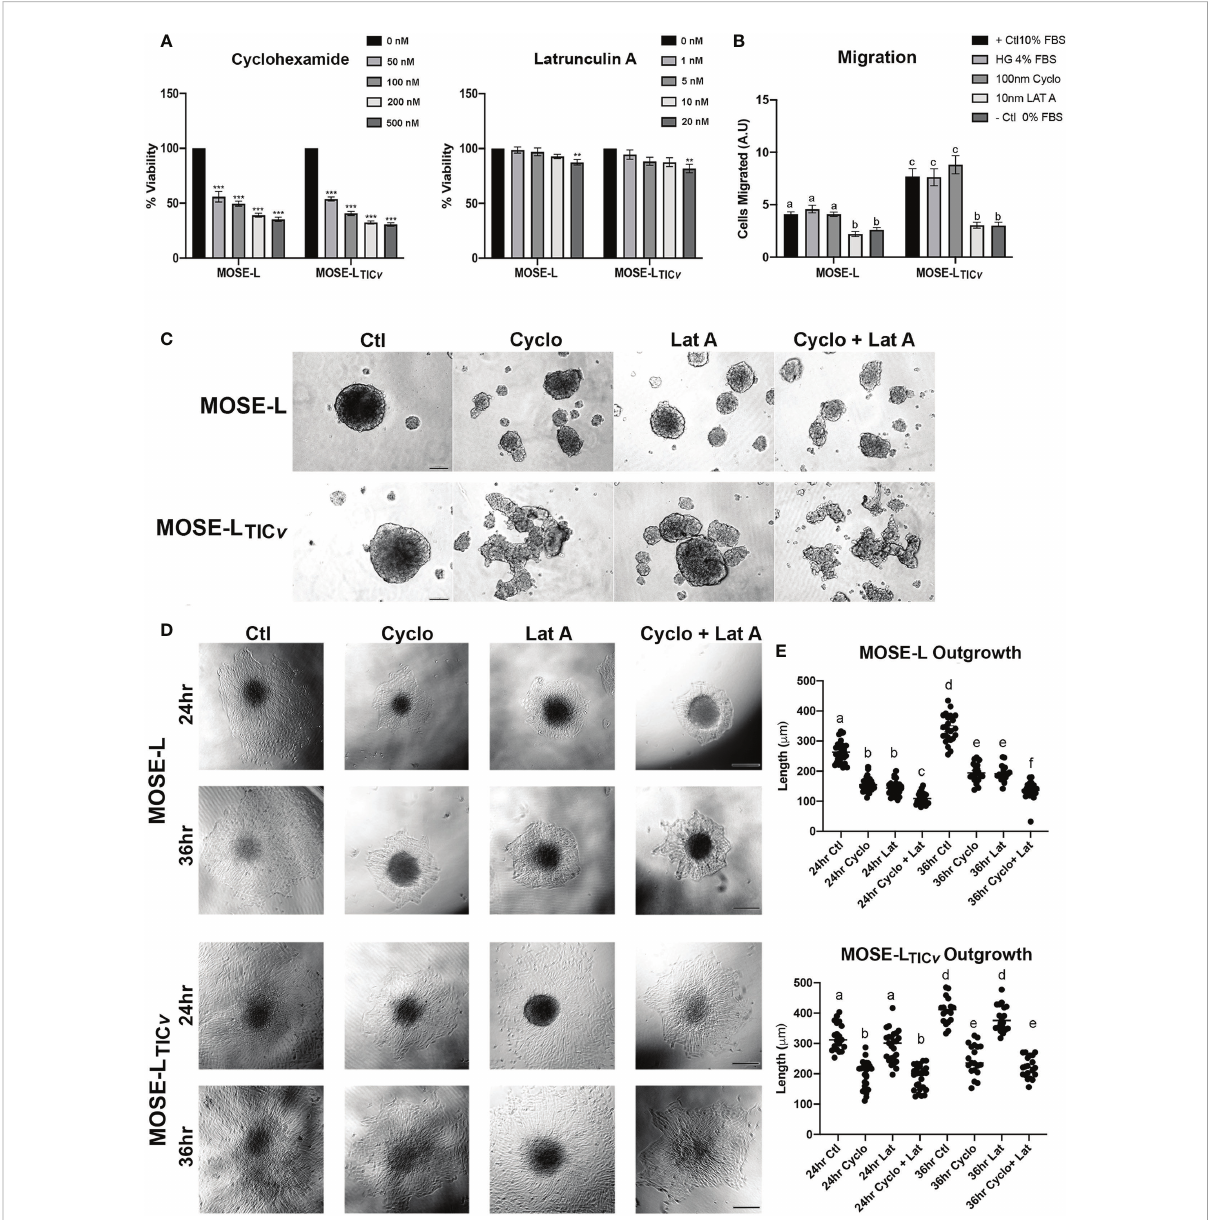
FIGURE 5 Differential effect of proliferation and migration inhibitors. (A) Inhibition of proliferation by treatment with Cycloheximide (50, 100, 200 and 500 nM) and Latrunculin A (1, 5, 10, and 20 nM). (B) Inhibition of migration after treatment with Latrunculin A (Lat A) and Cycloheximide (Cyclo) of adherent spheroids exposed to 4% FBS chemoattractant compared to positive (+; 10% FBS/4% High glucose (HG)) and negative (0% FBS) controls. Different letters indicate signi fi cant differences in cells migrating. (C) 24 h spheroid formation assay with 100 nM Cyclo, 10 nM Lat A or both drugs in ultra-low adherence conditions. (D, E) Effect of drug treatment for 24 and 36 h on spheroid outgrowth. Different letters indicate signi fi cant differences in outgrowth. Scale bar set at